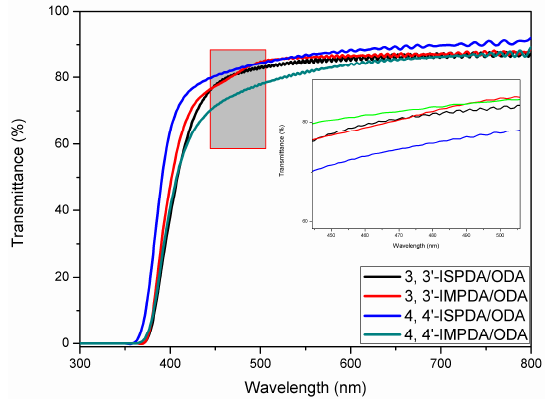
Figure 7. Representative stress-strain curves of isohexides-derived PEIs